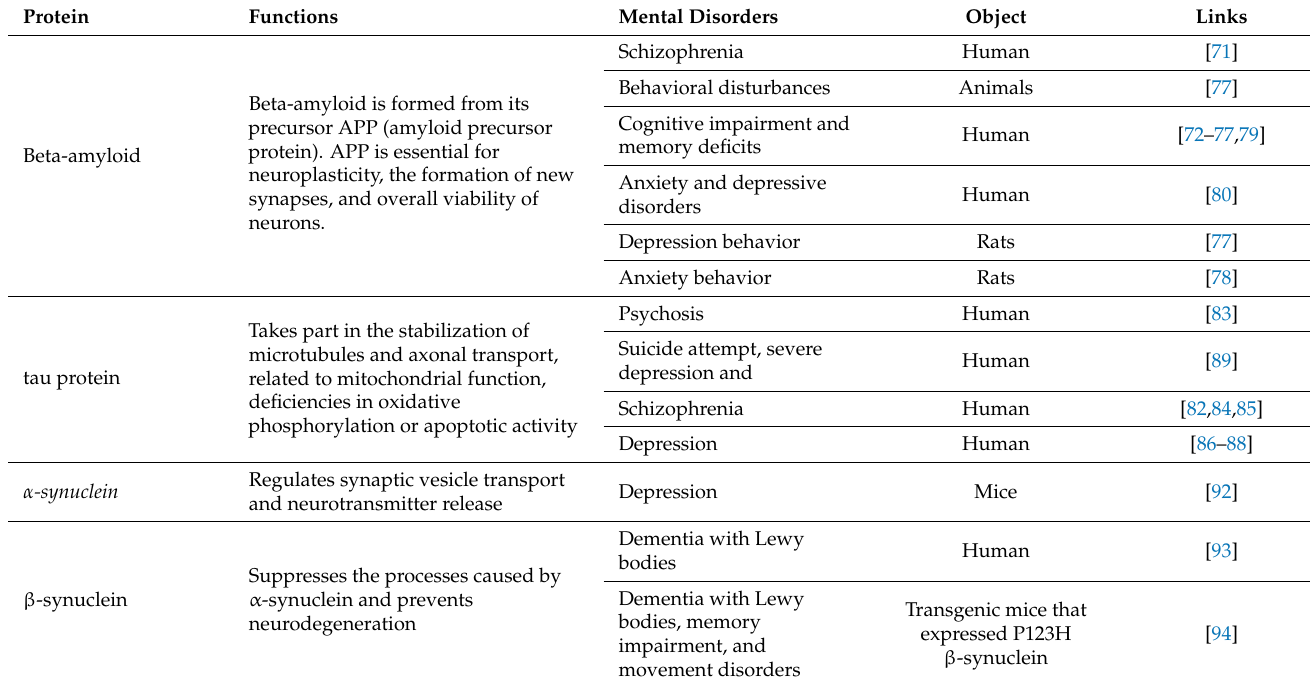
Table 1. Summary of data on aggregating proteins in psychiatric